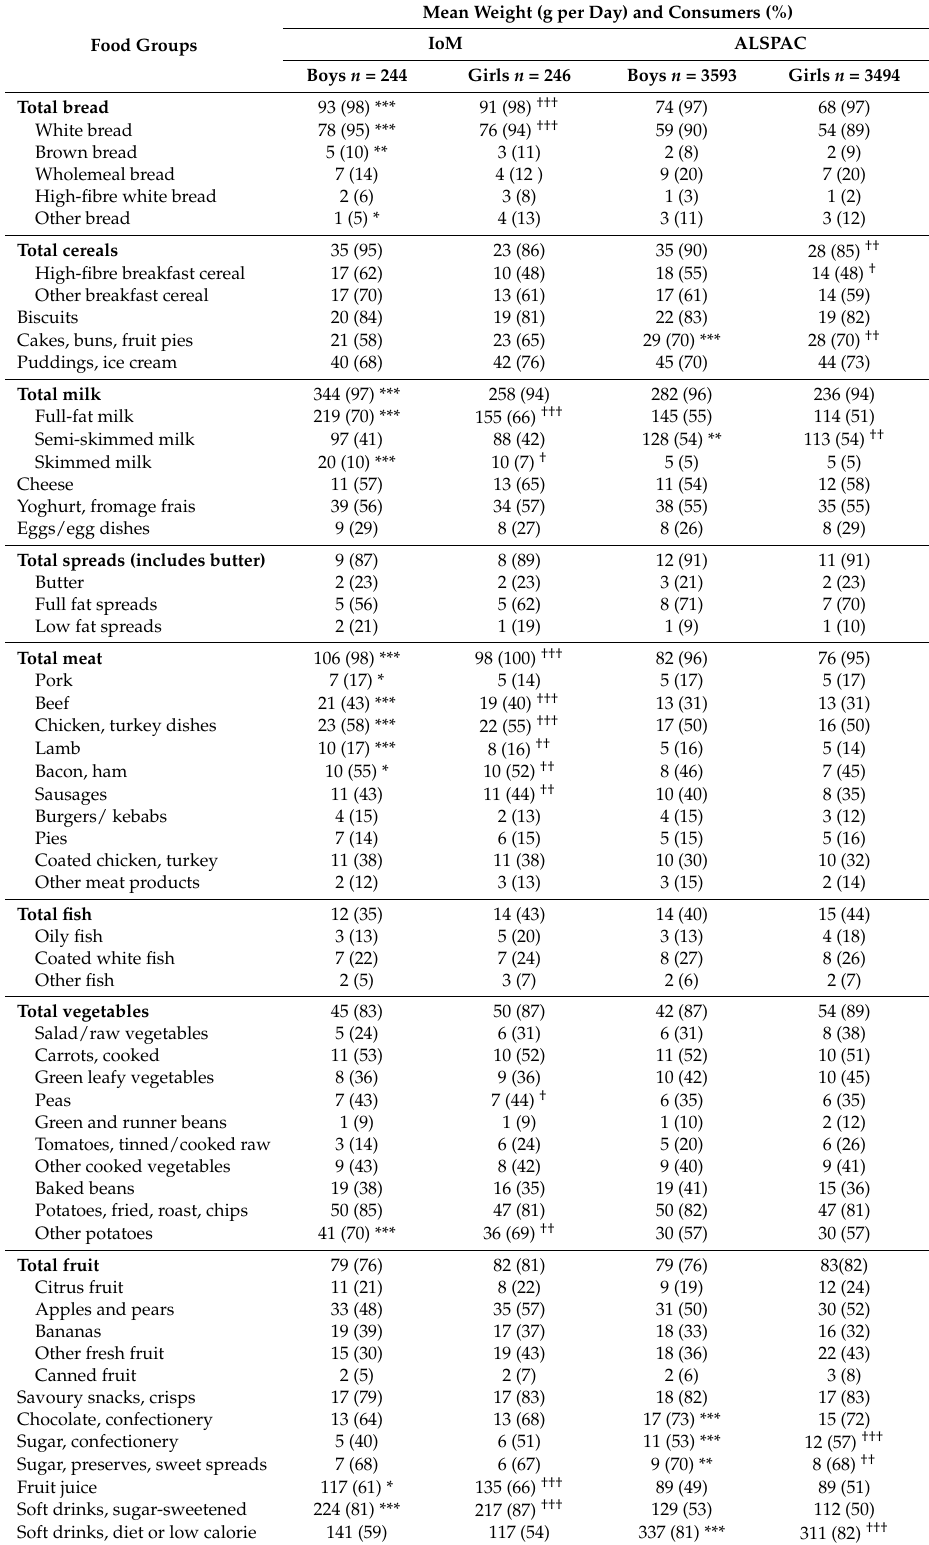
Table 4. Comparisons of daily food group intakes from food records in 7-year-old children in the IoM and ALSPAC by